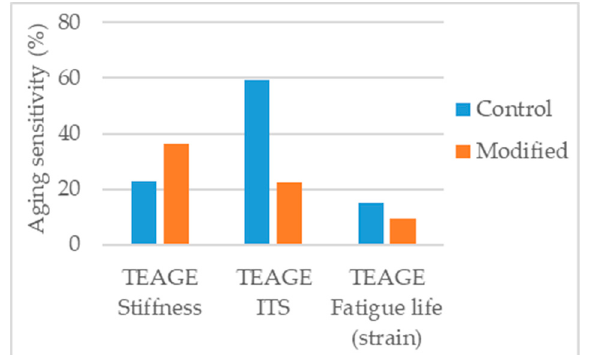
Figure 20. Aging sensitivity of the parameters considered in the study [131].